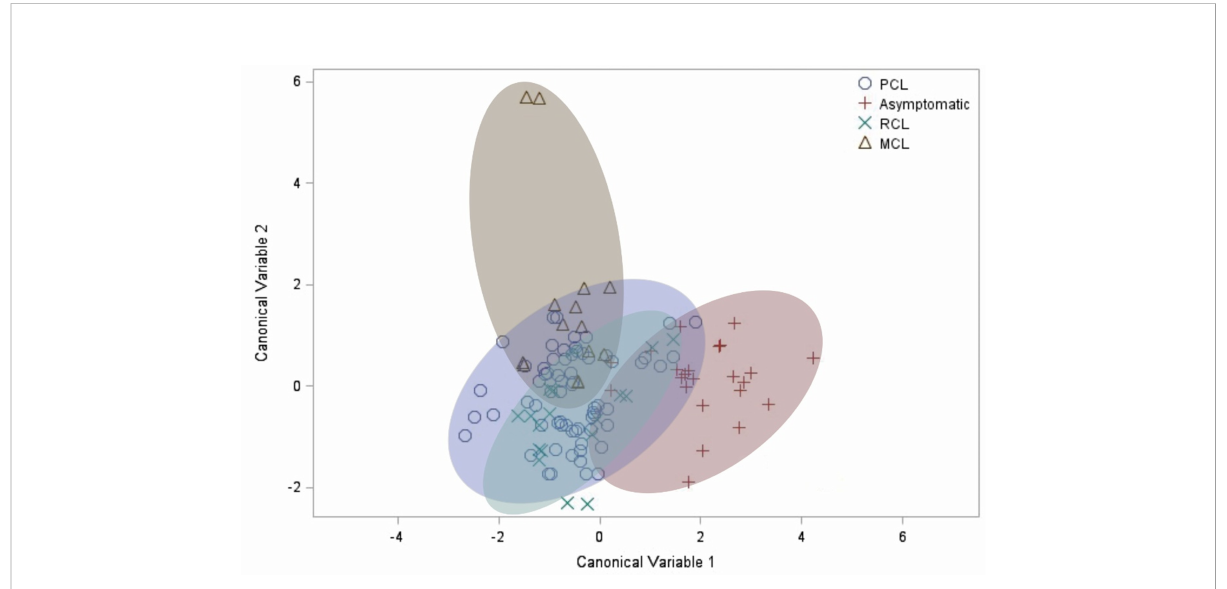
FIGURE 4 Canonical discriminant analysis. Each symbol represents a patient. The shaded clusters are dispersion ellipses for the four clinical manifestations. PCL, primary cutaneous leishmaniasis. RCL, recurrent cutaneous leishmaniasis. MCL, mucocutaneous